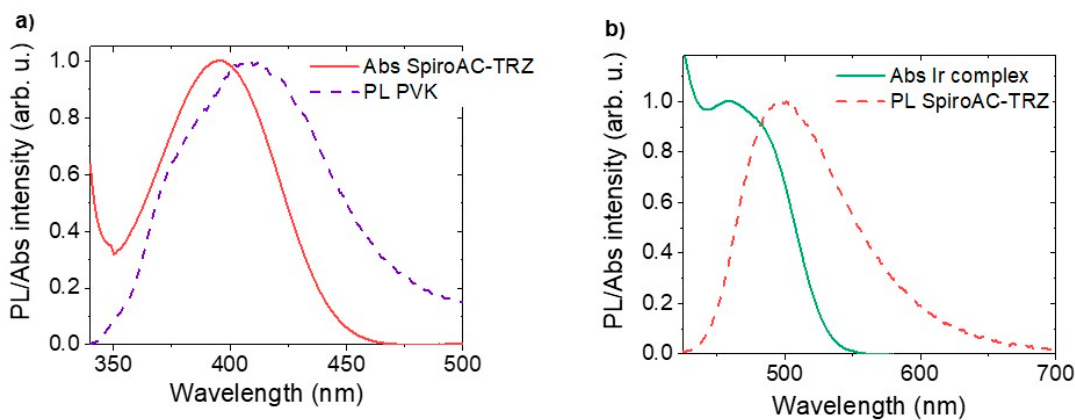
Figure 10. ( a ) Normalised PL spectrum of neat PVK matrix (film) and absorption spectrum of TADF emitters (chlorobenzene solution) ( b ) Normalised PL spectra of TADF emitter (embedded in PVK matrix) with absorption spectrum of Ir complex (chlorobenzene solution).